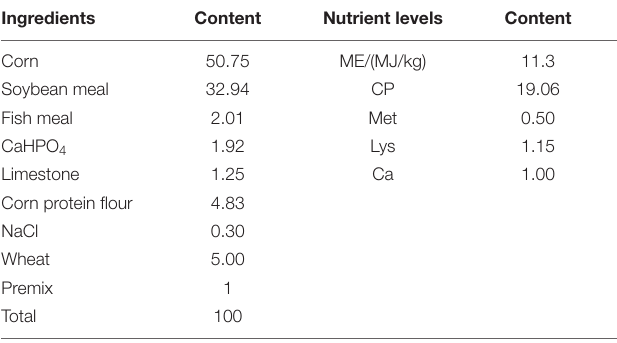
TABLE 1 | Composition and nutrient levels of basal diets (air-dry basis). Ingredients